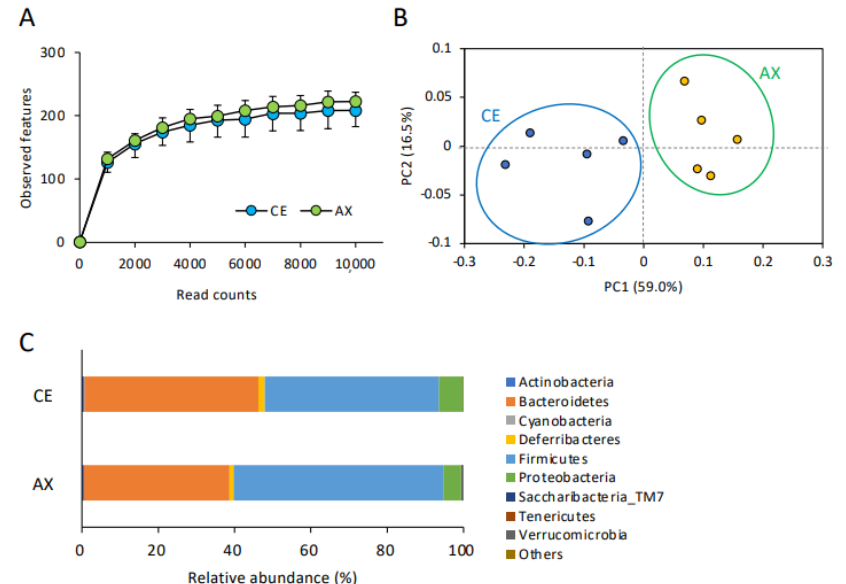
Figure 1. Effect of AX on the gut microbial diversity and composition: ( A ) The impact of AX on the α -diversity (observed features) of the gut bacteria analyzed by 16S rRNA sequencing (n = 5). Values and error bars indicate the mean ± SD. ( B ) Principal component analysis of the β -diversity values of the gut bacteria. ( C ) The effects of AX on the phylum-level gut bacterial composition.